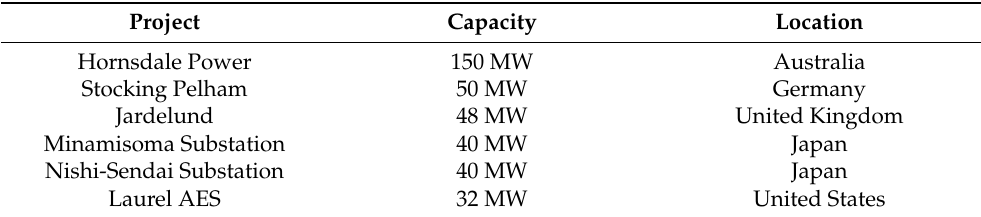
Table 5. Top-rated capacity Li-ion energy storage systems